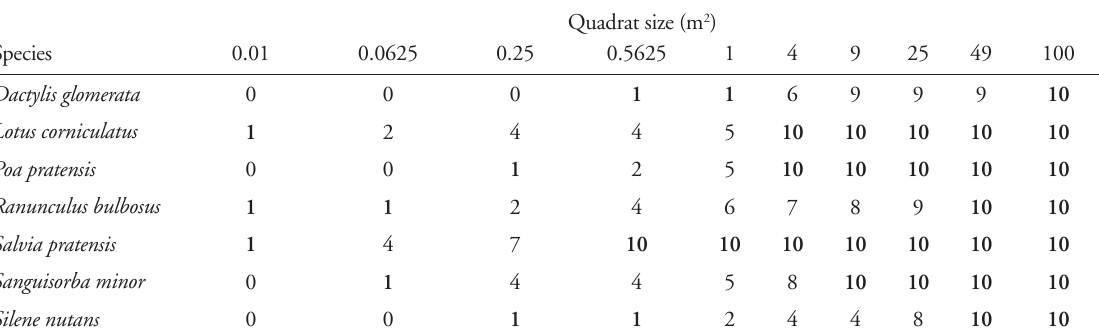
Table 3. Species switching from the satellite to the core class with increasing quadrat size. The numbers indicate the number of quadrats occupied by the species (ten quadrats per size were sampled). Bold: satellite (1) and core (10)